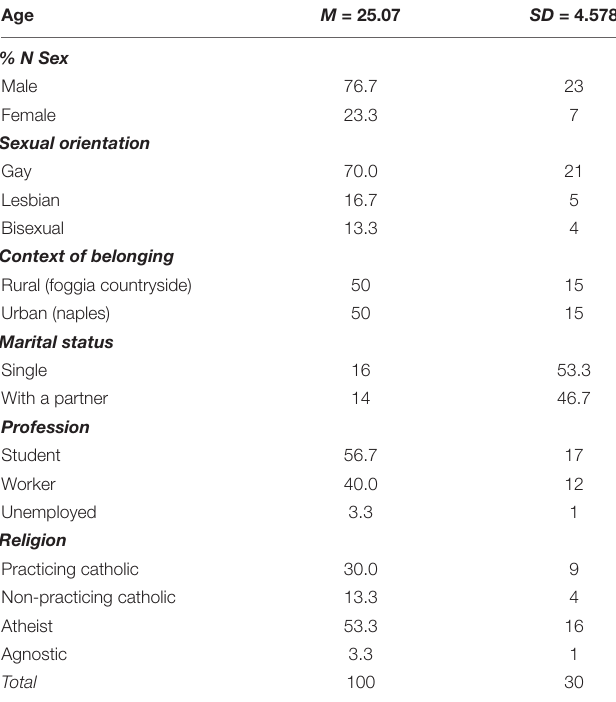
TABLE 1 | Participants’